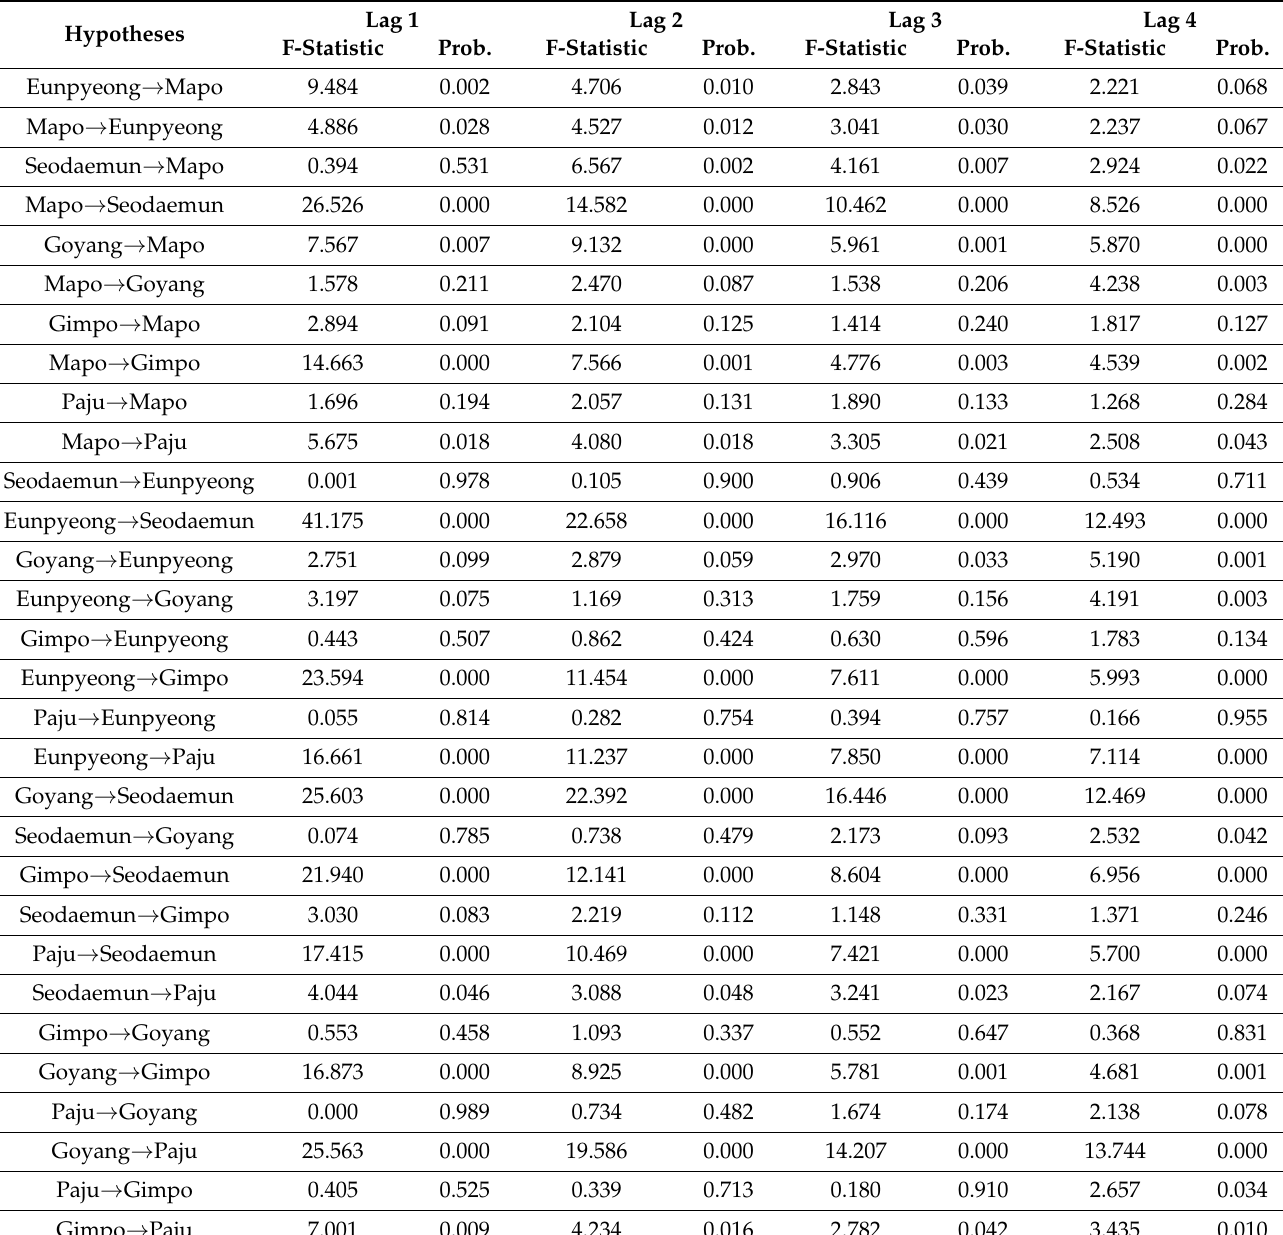
Table 12. Granger causality analysis of sales price in Northwest region and Gyeongeui